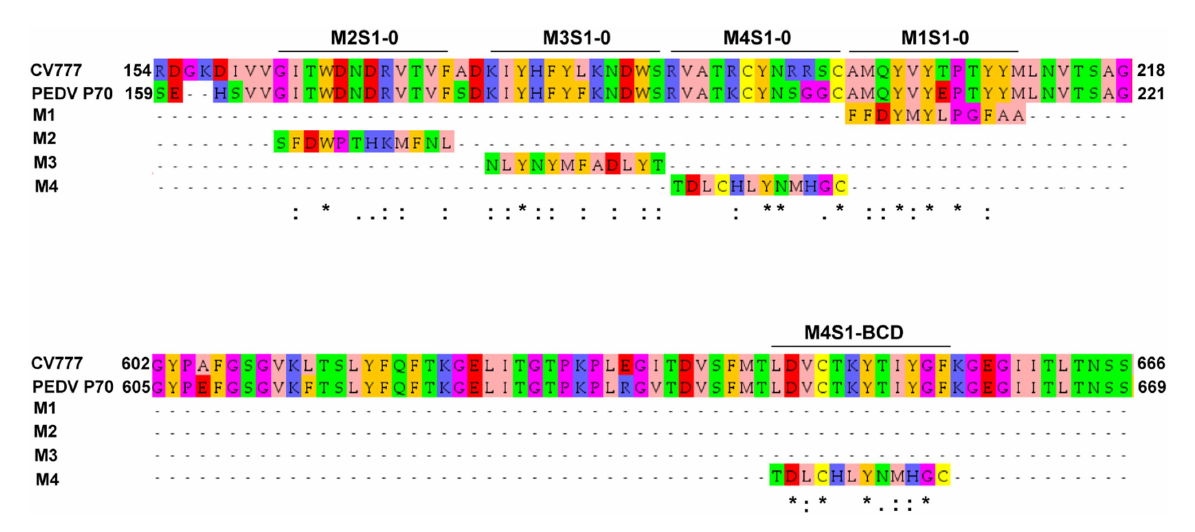
FIGURE 2 Linear amino acid sequences of S1-0 (residues 154–218/221) and S1-BCD (residues 602–666/669) sub-domains of S1 proteins of PEDV strains CV777 (GI; GenBank: AEX92968.1) and P70 (GII) showing regions matched with the phage mimotope types 1–4 (M1-M4), i.e., the S1-0 residues 165GITWDNDRVTVF176 matched with M2 (M2S1–0), 179KIYHFYFKNDWS190 matched with M3 (M3S1–0), 191RVATKCYNSGGC202 matched with M4 (M4S1–0), 203AMQYVYEPTYYM214 matched with M1 (M1S1–0), and S1-BCD sub-domain residues 646LDVCTKYTIYGF657 matched with M4